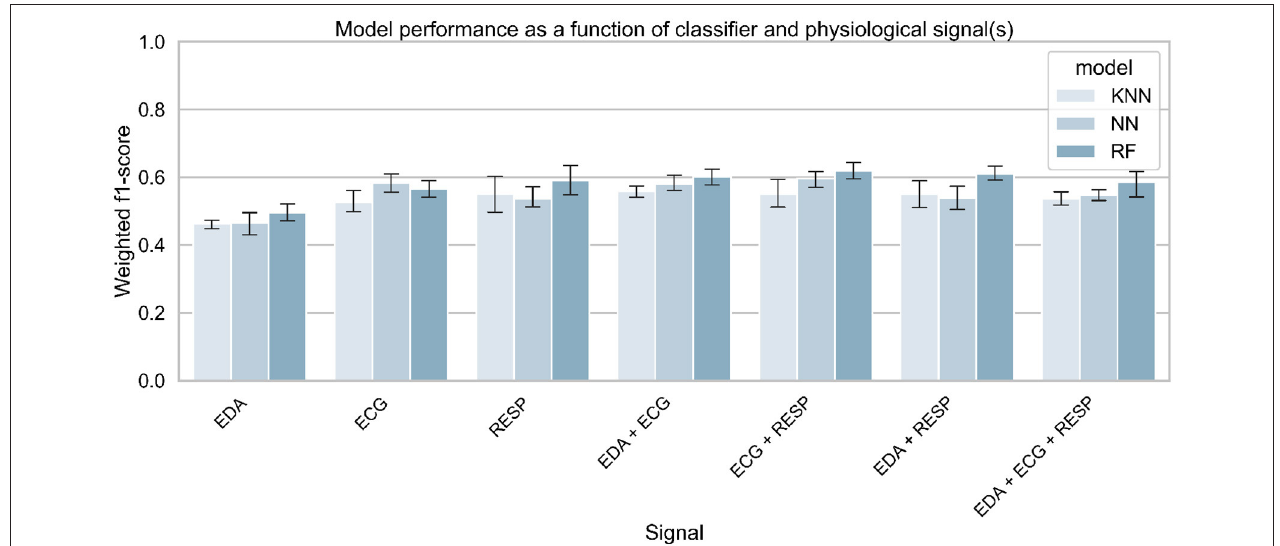
FIGURE 16 | Classification accuracy for predicting task modality (visual vs. auditory), as a function of selected physiological signals and classifier. A threshold for task performance of 100 was selected.